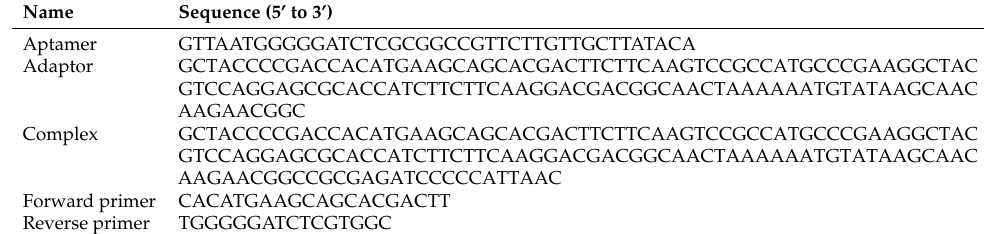
Table 1. Oligonucleotide sequences used in the